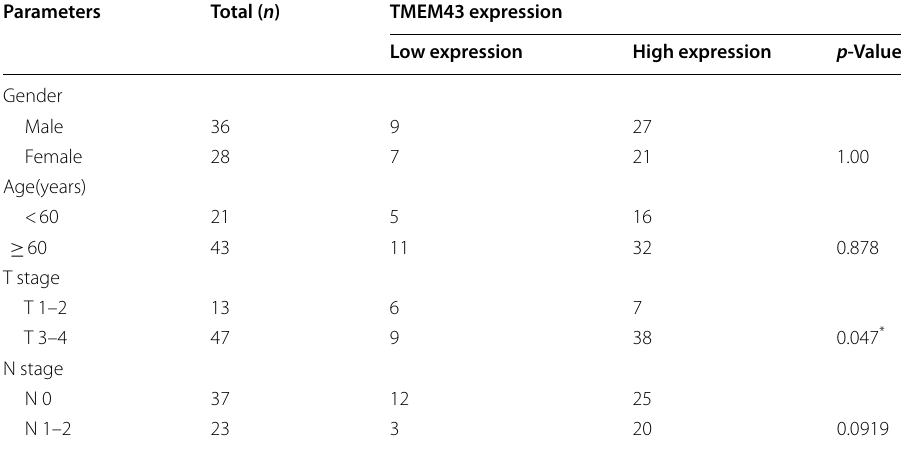
Table 1 Relationship between the clinicopathological variables and TMEM43 expression in pancreatic cancer